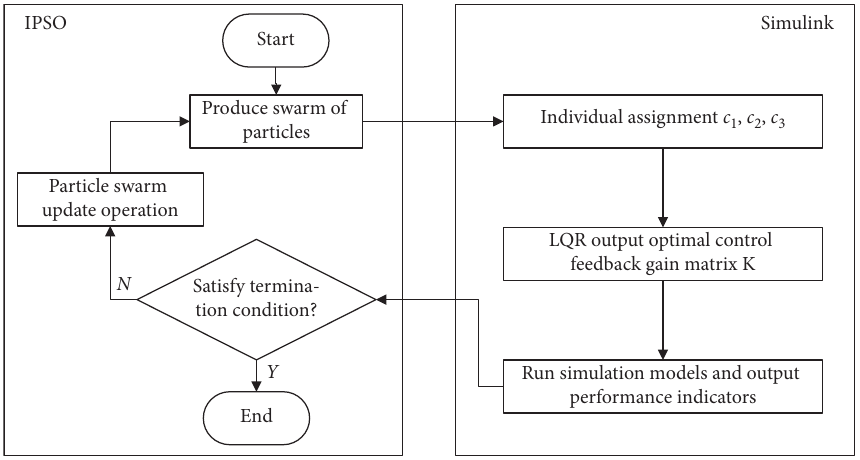
Figure 1: The procedure of controller parameters